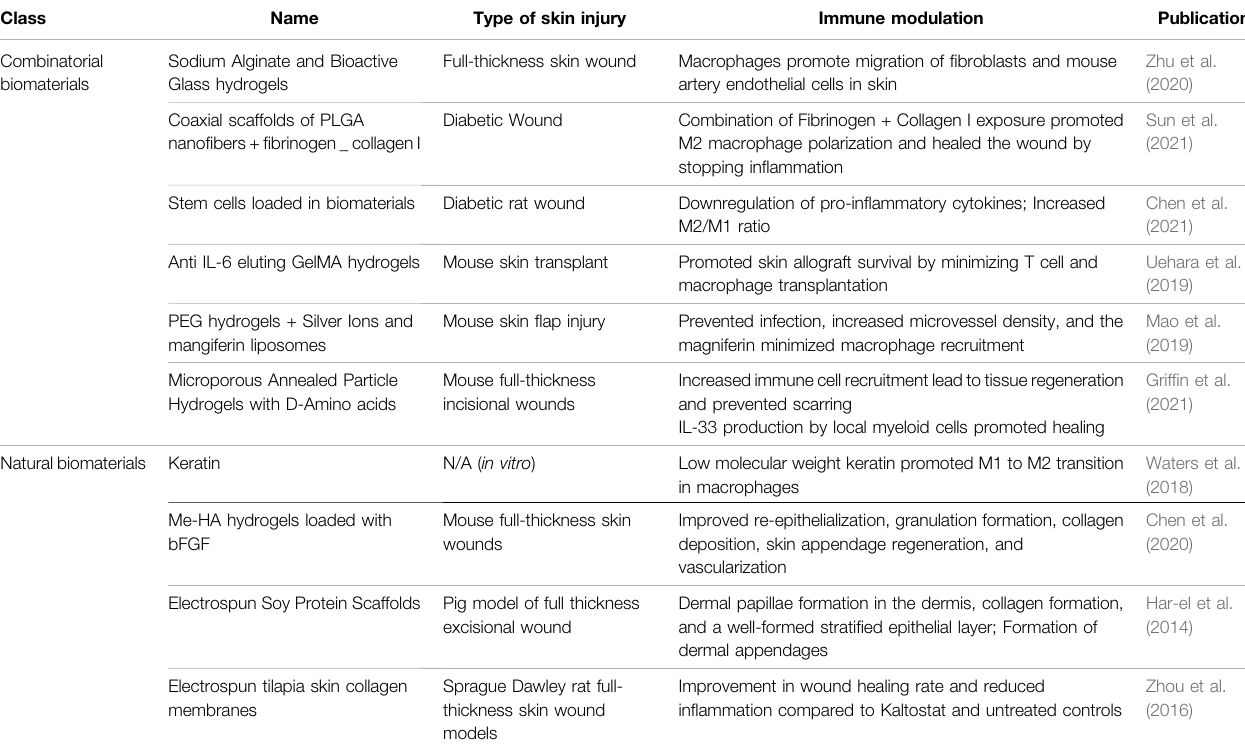
TABLE 2 | Biomaterials for skin regeneration and their immunomodulatory properties.